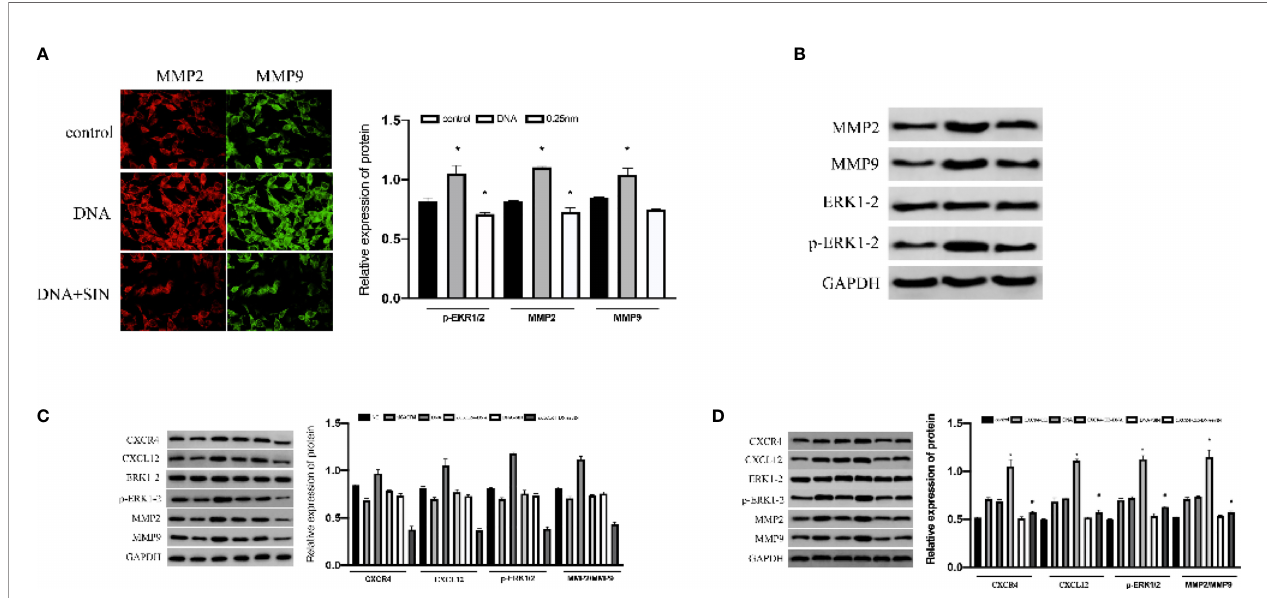
FIGURE 6 | Interference of tumor-derived DNA with sinomenine hydrochloride affects the ERK/MMP signaling pathway through the CXCL12/CXCR4 axis in HCC cells. (A) Immuno fl uorescence examination of the expression of p-ERK1/2 and MMP2/9 in cells (×200). (B) WB assay to examine the expression of p-ERK1/2 and MMP2/9 in cells. (C) The expression of p-ERK1/2, MMP2, and MMP9 proteins in SK-Hep1 cells after siCXCR4 transfection. (D) The expression of p-ERK1/2, MMP2, and MMP9 proteins in SK-Hep1 cells after CXCR4-OE transfection. *P <